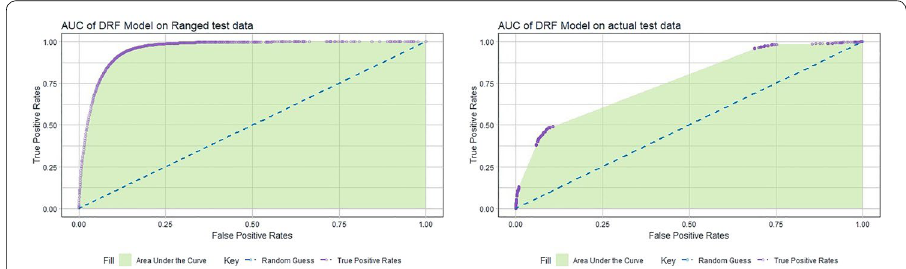
Fig. 8 Area under the curve of DRF models which are trained